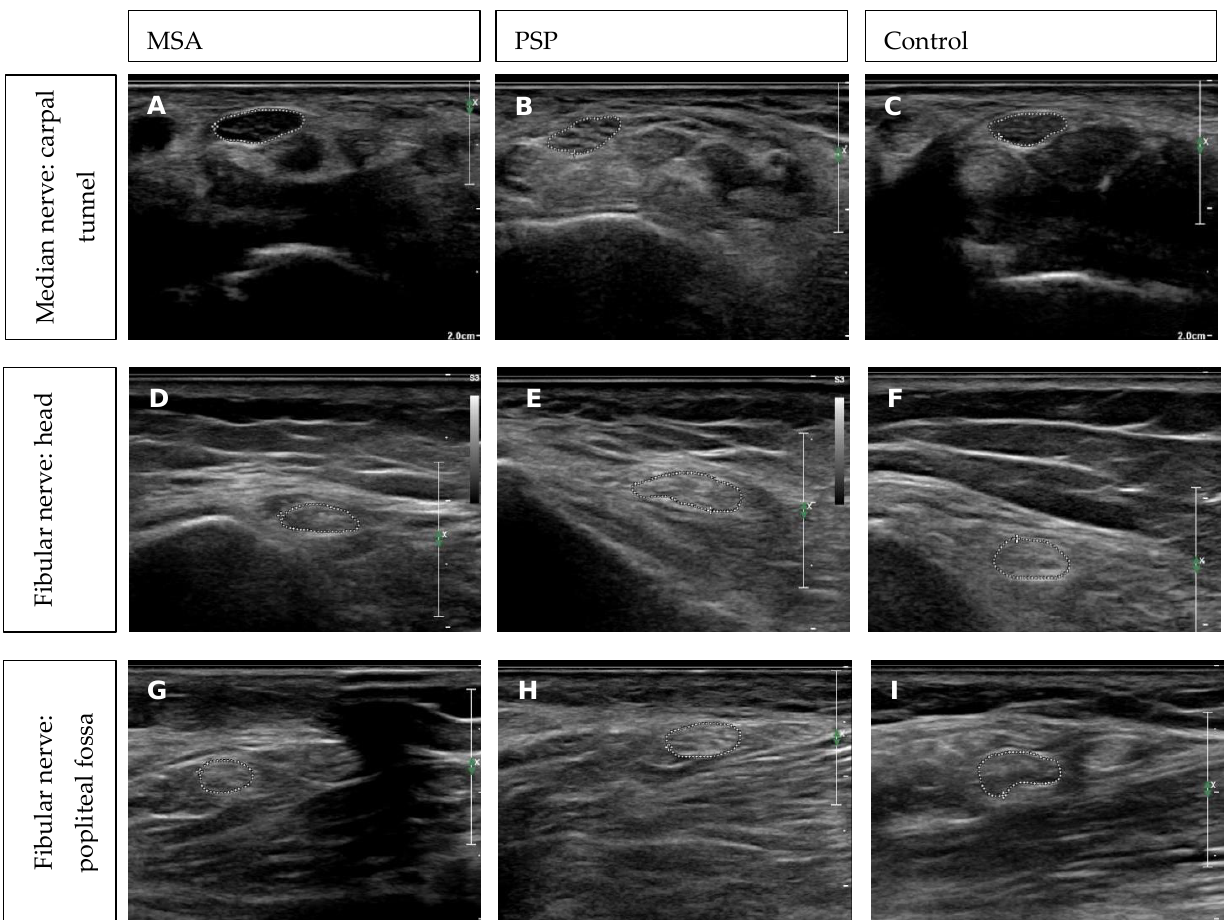
Figure 3. ( A – I ) High resolution ultrasound of peripheral nerves at entrapment sites of MSA ( A , D , G ) vs. PSP ( B , E , H ) vs. control. ( C , F , I ) ( A – C ) Median nerve: carpal tunnel. ( D – F ) Fibular nerve: head. ( G – I ) Fibular nerve: popliteal fossa.